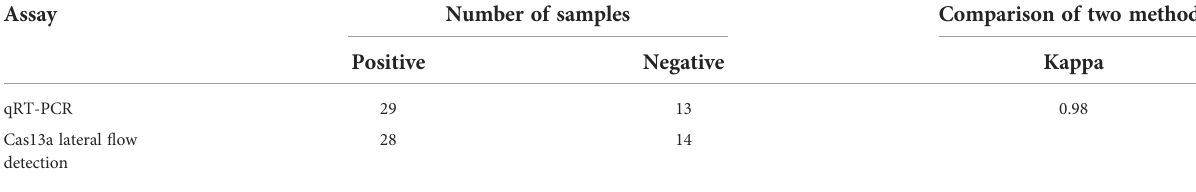
Table 2 Detection results of clinical samples in Cas13a lateral fl ow detection and qRT-PCR assays.